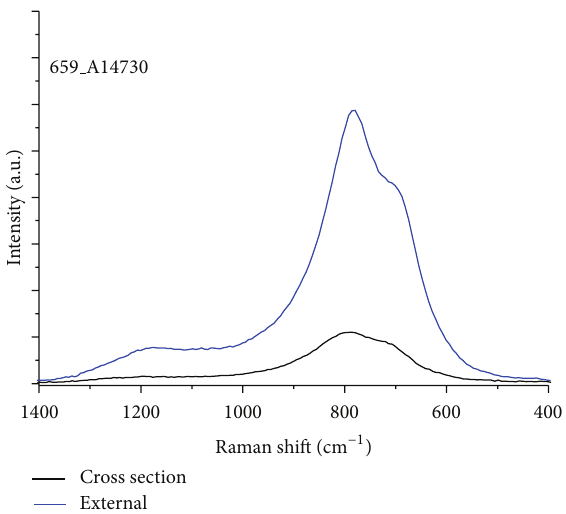
Figure7:Ramanspectrumofthesample659A14730,aclearwasteof production of the furnace VII, taken along the internal and external surfaces.